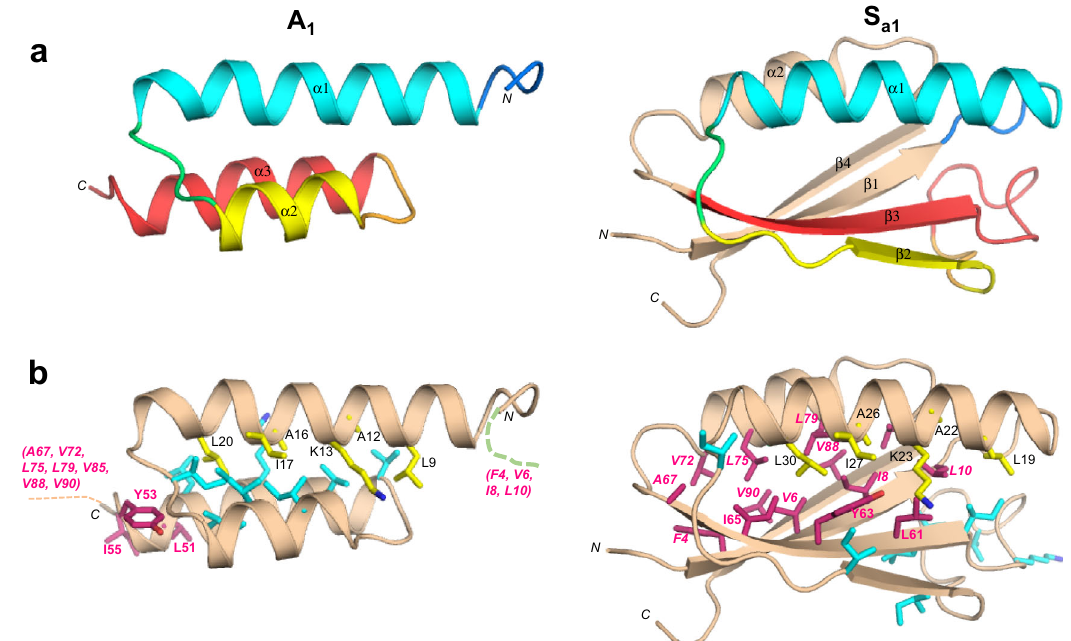
Fig. 4 | Structural differences between the 100% sequence identical regions of A 1 and S a1 . a Main chain comparisons. (Left panel) CS-Rosetta structure of A 1 with color coding for secondary structured elements. (Right panel) Corresponding color-coded regions mapped onto the CS-Rosetta structure of S a1 , illustrating changesinbackboneconformation.Regionsoutsidethe56aminoacidsequenceof A 1 areshowninwheat. b Sidechaincomparisons.(Leftpanel)Residuescontributing